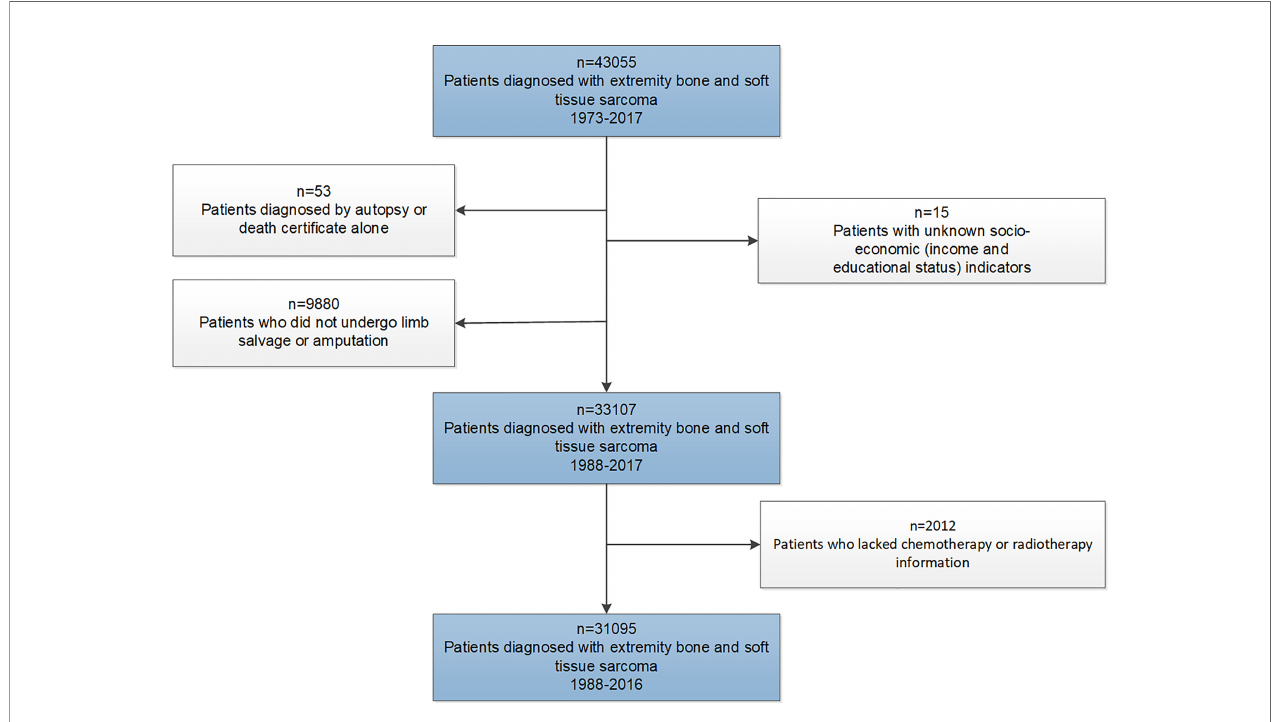
FIGURE 1 | Flowchart describing initial dataset and exclusions leading to fi nal study